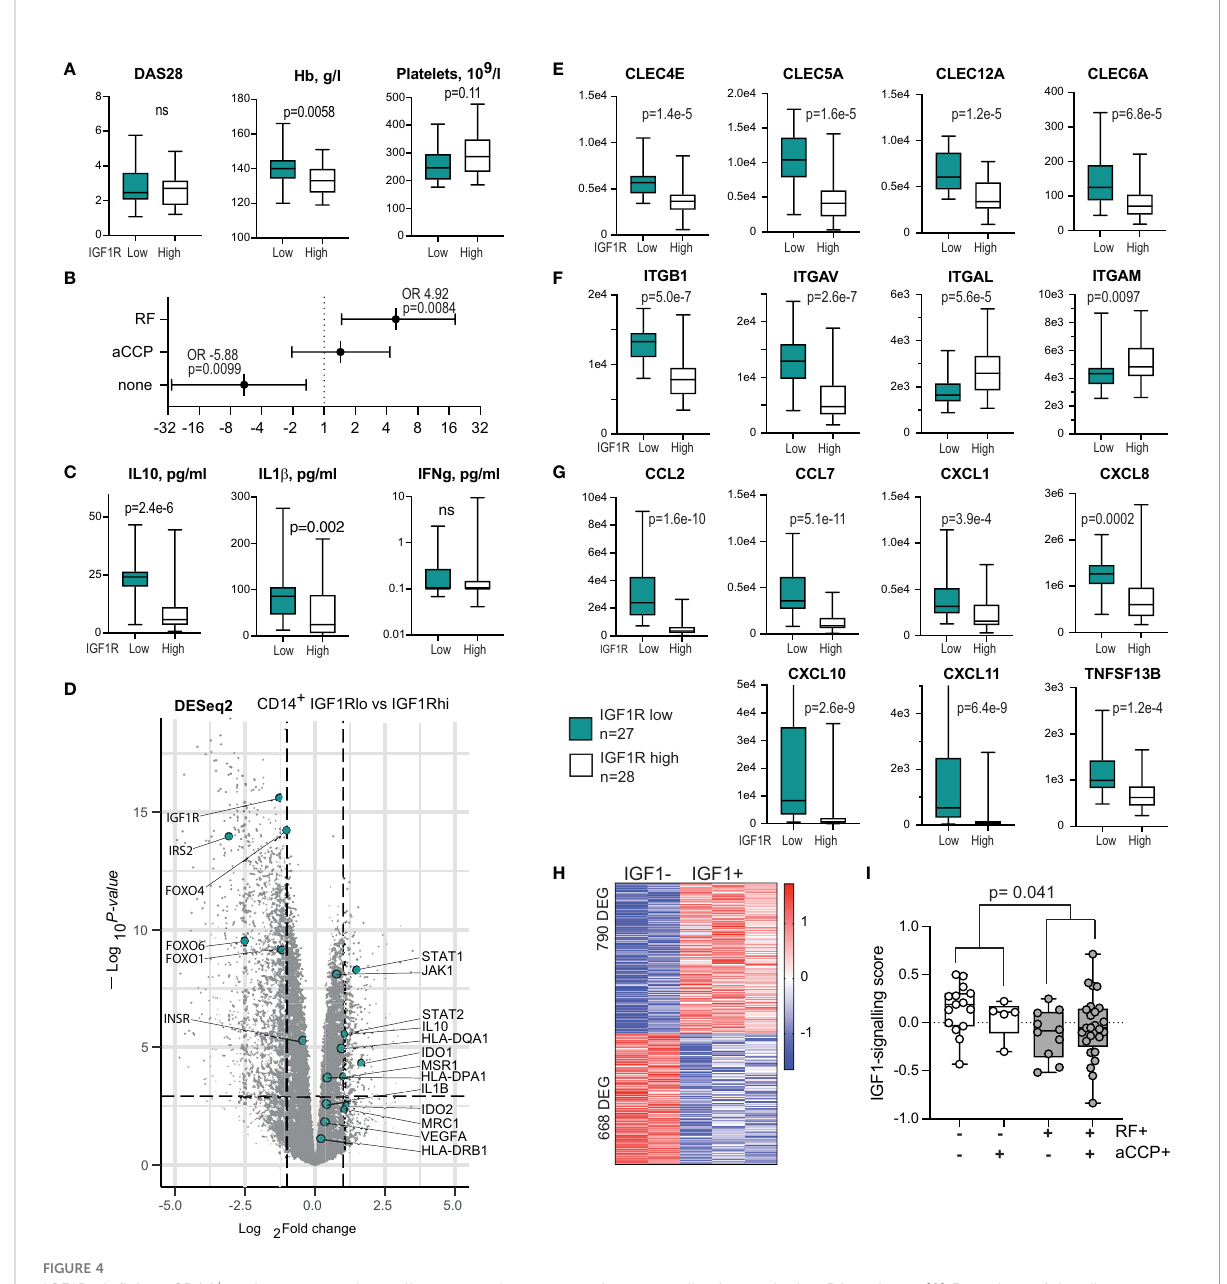
FIGURE 4 IGF1R-de fi cient CD14 + antigen-presenting cells are prevalent among the autoantibody-producing RA patients. (A) Box plots of the disease activity score (DAS28), haemoglobin level and platelet count in RA patients with low (n=27) and high (n=28) IGF1R expression in CD14 + cells. (B) Forest plot of odds ratio for antibody production between IGF1R lo and IGF1R hi patients. (C) Box plots of cytokine levels in supernatants of IGF1R lo and IGF1R hi CD14 + cells. (D) Volcano plot of whole-genome transcriptomics in IGF1R lo and IGF1R hi CD14 + cells, by RNA-seq. (E) Box plot of C-type lectin receptors. (F) Box plots of integrin expression. (G) Box plots of chemokine production. (H) Heatmap of the genes differentially expressed in response to IGF-1 stimulation and comprising IGF1-signature score in CD14 + cells. (I) Box plots of IGF-1-signature score in samples with different pattern of autoantibody